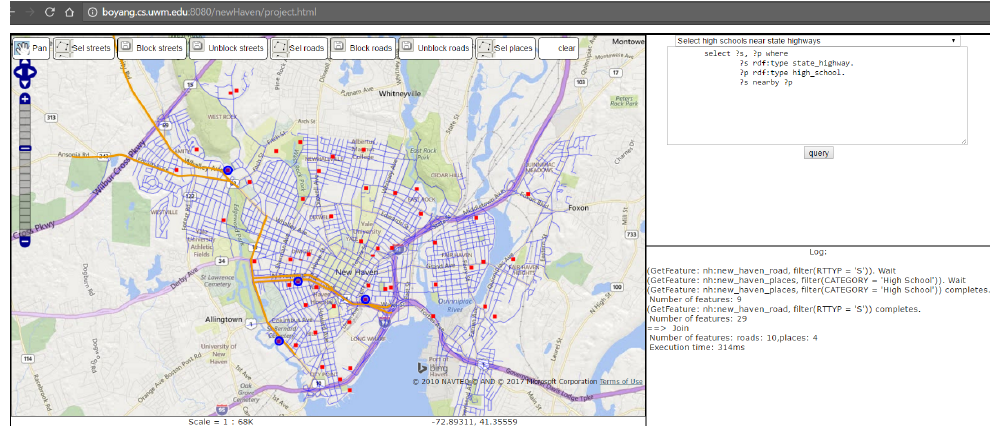
Figure 5. State highways near high schools.